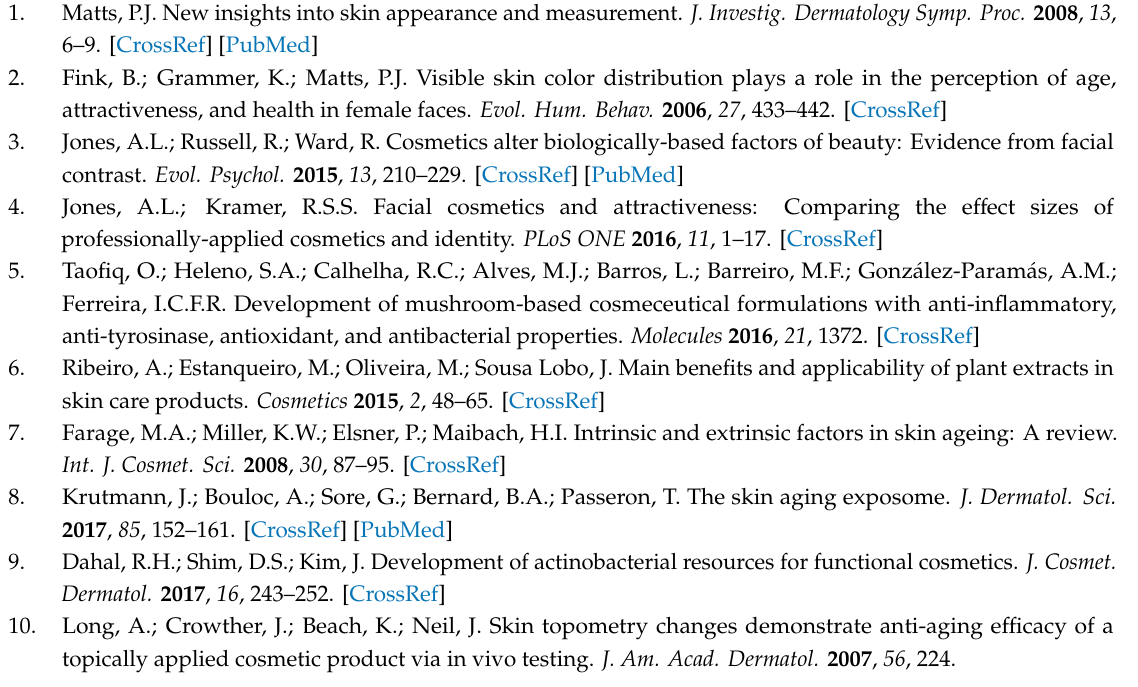
Table S9: Composite amino acids from T65 ethyl acetate extract, Table S10: Fatty acids from ethyl acetate extract of strain T65, Table S11: Zone of inhibition of T65 crude extract from five di ff erent solvent systems, Table S12: Zone of inhibition of purified crude T65 compounds against gram-positive and gram-negative pathogens, Table S13: Determination of T65 immersion using BET analyses, Table S14: Stability of formulated cream in di ff erent conditions and